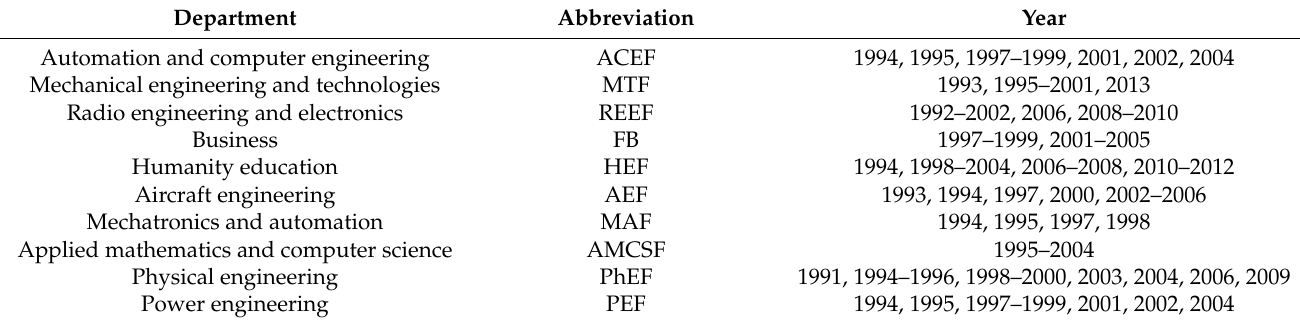
Table 1. Natural distribution of tested students by departments and years.